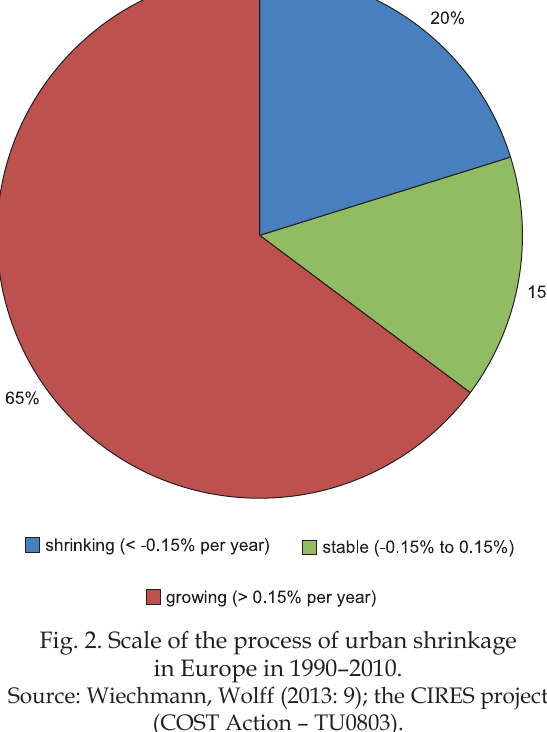
Fig. 2. Scale of the process of urban